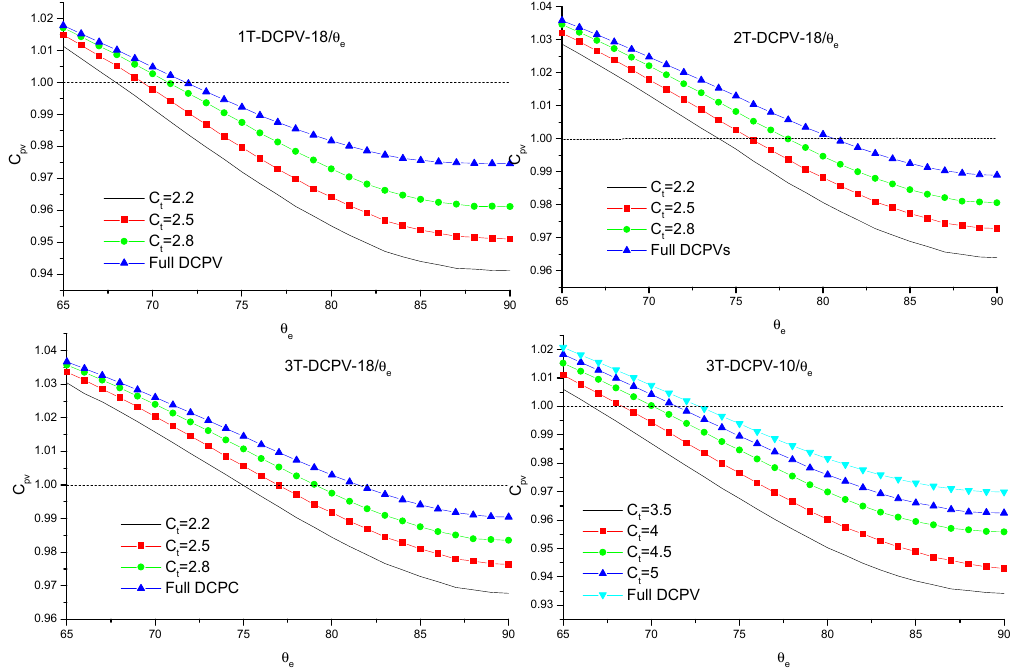
Figure 24. Effects of θ e on the annual average photovoltaic efficiency of solar θ Figure 24 . Effects of e on the annual average photovoltaic efficiency of solar cells.